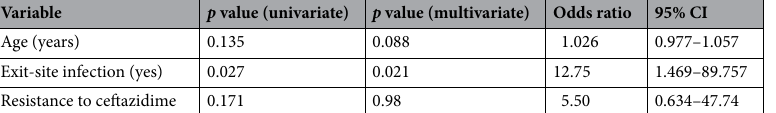
Table 4. Predictors of non-resolution of non-fermenting Gram-negative bacilli peritonitis in peritoneal dialysis—Logistic Regression Analysis.